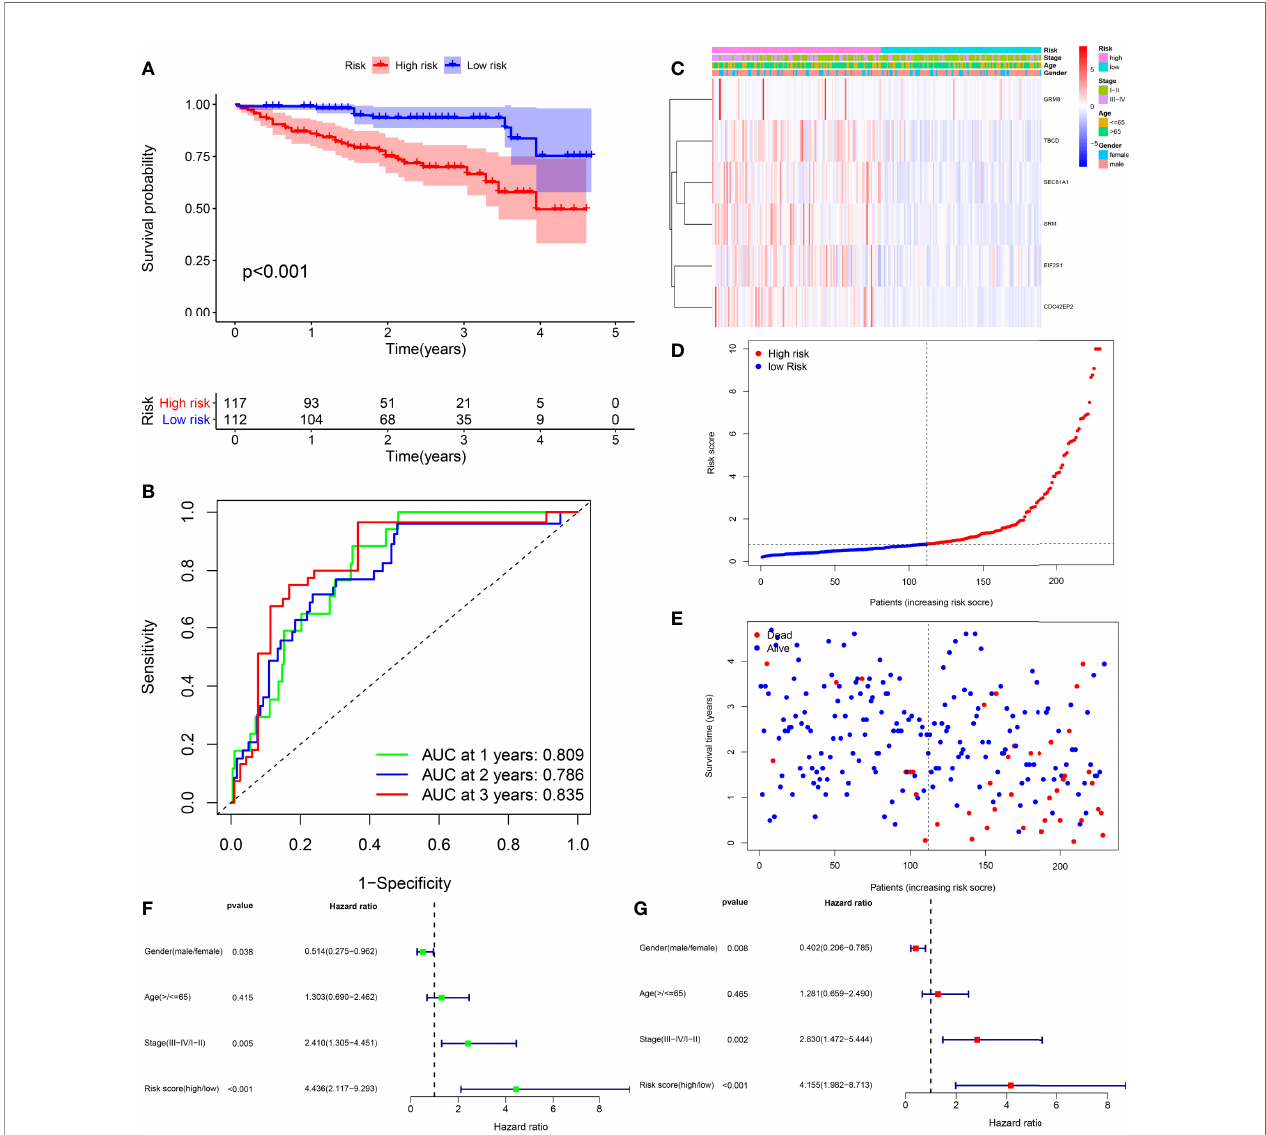
FIGURE 5 | Prognostic assessment of the prognostic model in the ICGC cohort (A, B) The Kaplan – Meier survival analysis and time − dependent ROC analysis of the signature for predicting the overall survival of patients in the ICGC cohort (n = 229) (C) The heatmap of the six-gene signature (D) The survival status of patients (E) The distribution of the risk score (F, G) Univariate and multivariate regression analyses of the relation between the risk score and clinicopathological characteristics regarding the overall survival in the ICGC cohort (green represents univariate analysis, and red represents multivariate